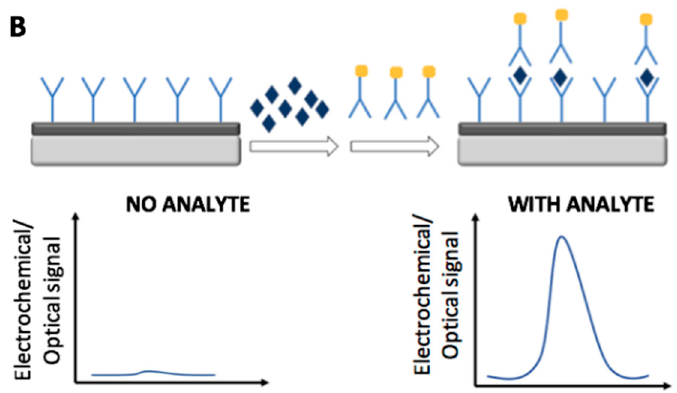
Figure 1. Schematic representation of electrochemical and optical non-competitive detection strategies by the use of immunosensors: label free assay ( A ) and labeled assay ( B ).